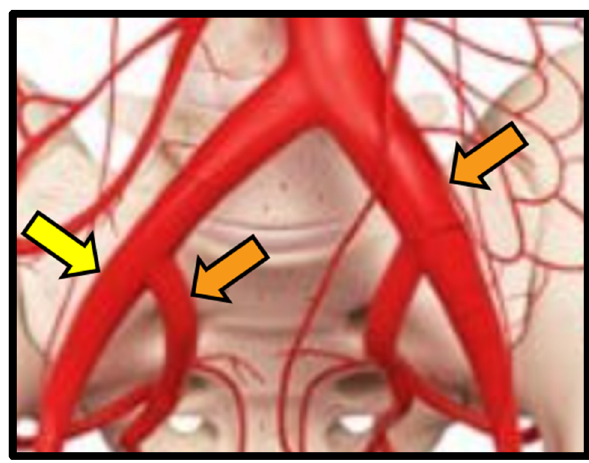
Figure 1: Site of UAF. Yellow dart: case 1 ( proximal external iliac artery ) . Orange darts: case 2 ( distal left common iliac artery and proximal left hypogastric artery )